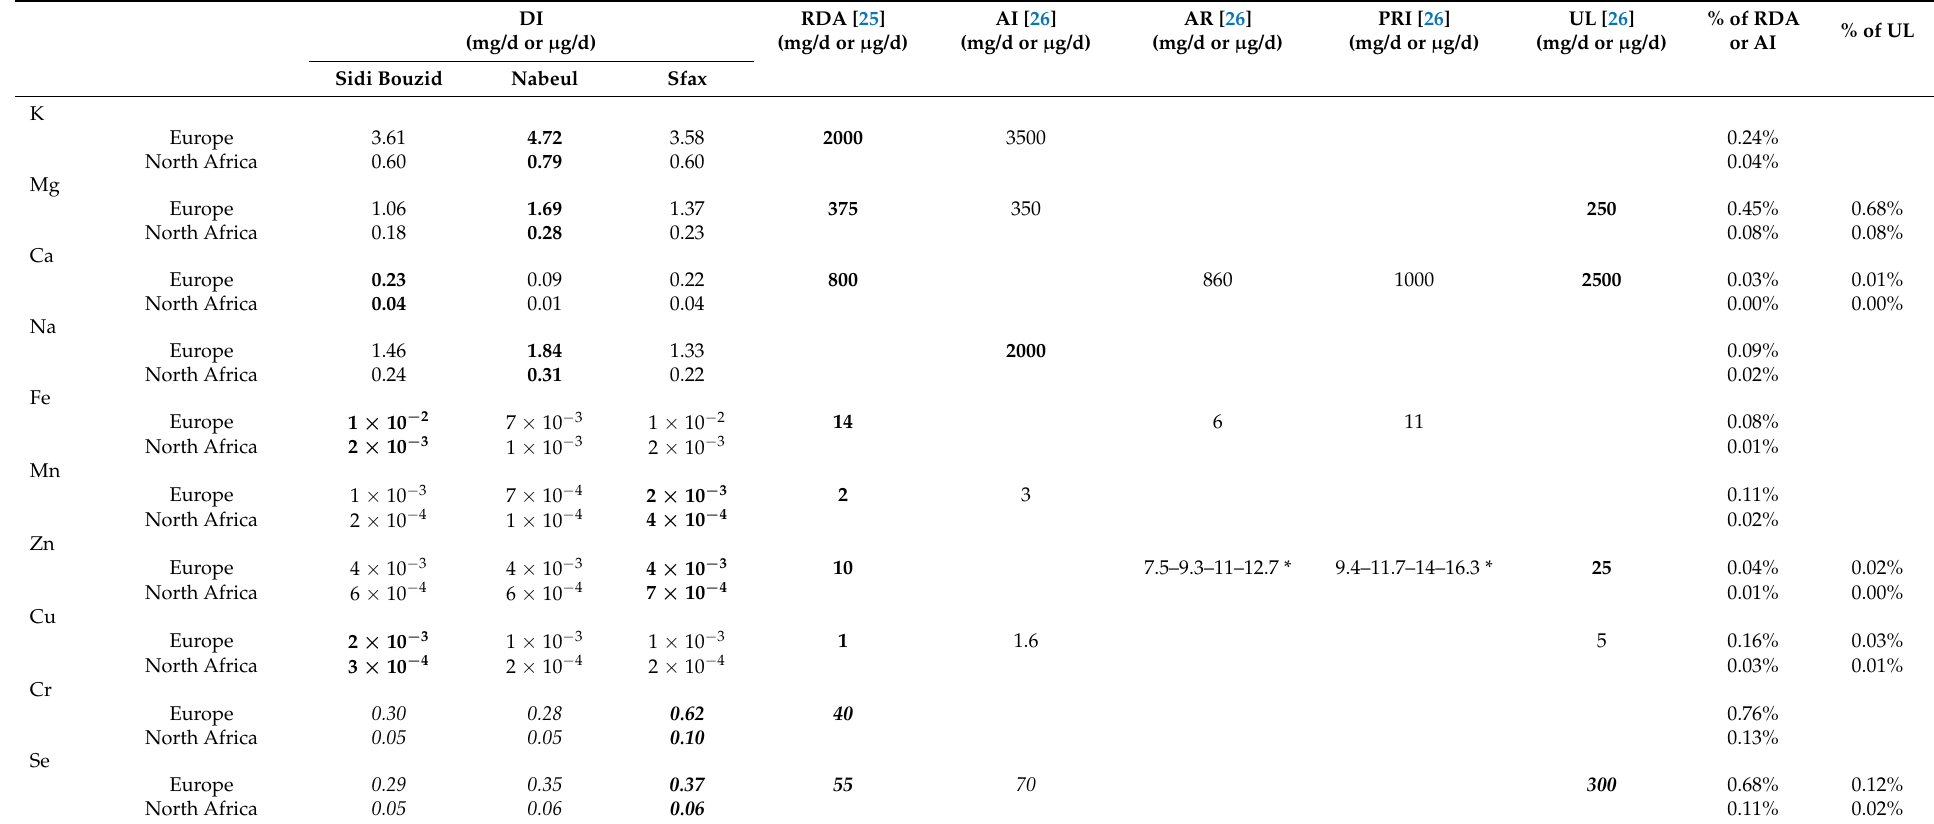
Table 4. Shares of dietary reference values of essential elements by consumption of honey from the three districts of